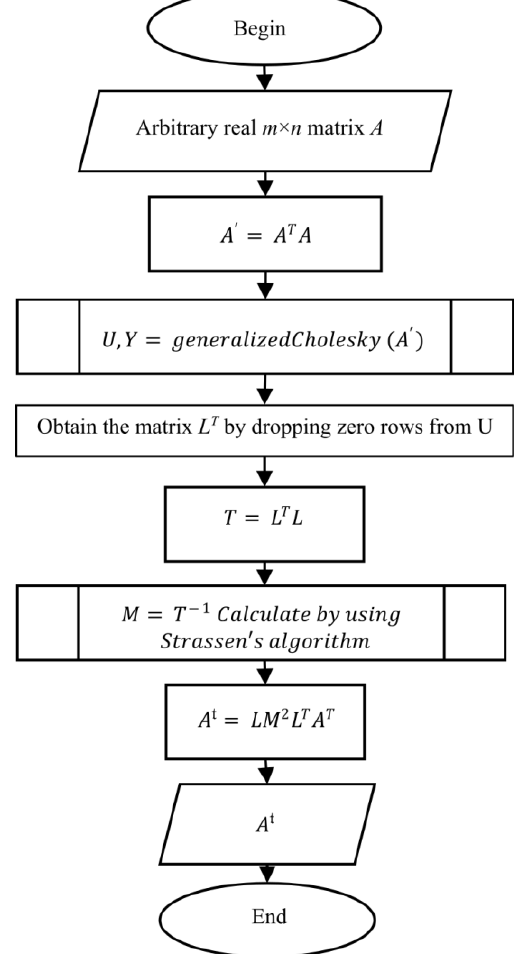
Figure 3. Algorithm 4.3 (Figure A3) : Computing the pseudoinverse in matrix multiplication time complexity.